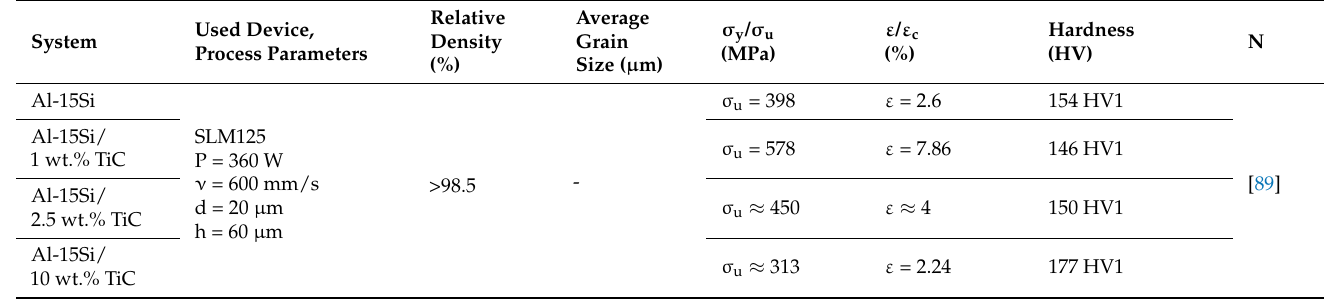
Table 2. Characteristics of carbide reinforced AMCs fabricated by laser powder-bed